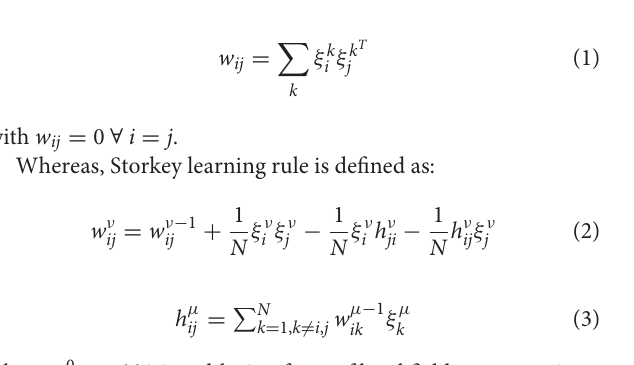
FIGURE 2 | Digital ONN architecture with fully parallel implementation of neurons and a combinatorial implementation of the arithmetic synapse